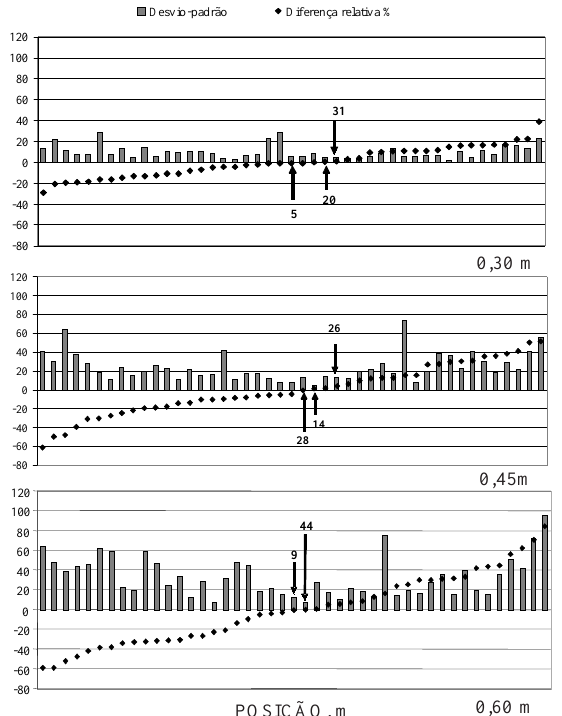
Figura 5. Diferença relativa média intertemporal e desvio-padrão para o potencial mátrico da água no solo (kPa), em três profundidades, segundo uma transeção de 50 pontos espaçados de um metro. Valores em destaque indicam os pontos que devem ser adotados para medidas representativas da média de potencial mátrico do